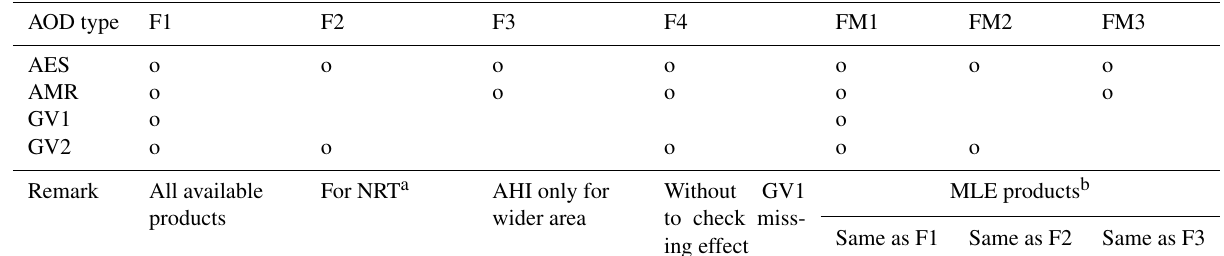
Table 1. Satellite dataset used for the fusion products. Four entries F1–F4 and three entries FM1–FM3 represent ensemble-mean fusion and MLE fusion